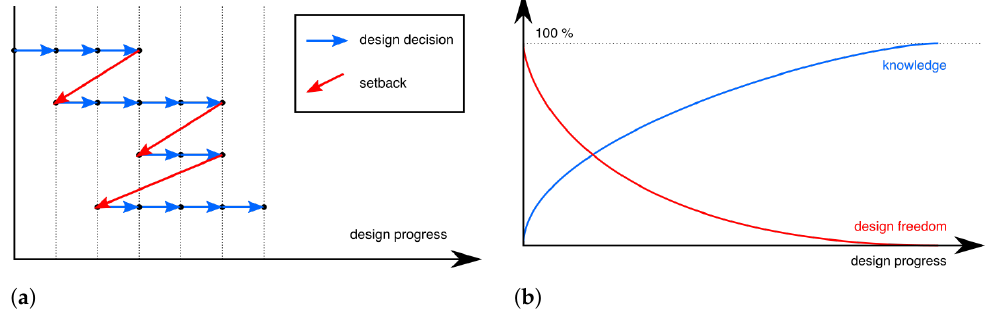
Figure 1. Setbacks are normal in product development, but their opportunity cost increases as the design progresses, which leads to the design paradox. ( a ) Product development is characterised by steps forward and setbacks due to the violation of design requirements. ( b ) The design paradox: as designers gain knowledge on how to design the product, they lose the freedom to modify the